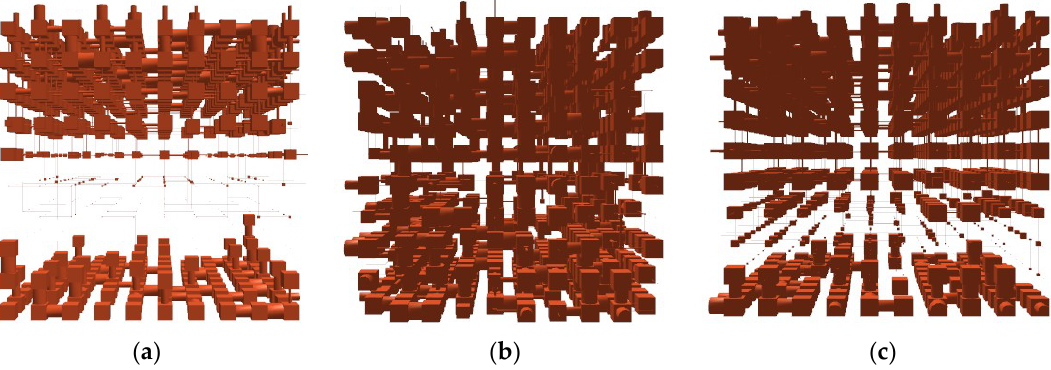
Figure 2. Models of the structures made with PoreXpert ® software for the untreated nail ( a ) and the nails incubated in water ( b ) or in 1:1 hydro–alcoholic mixture ( c ).